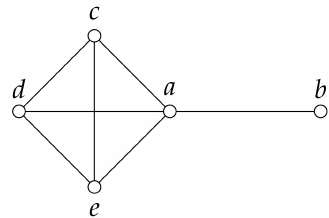
Figure 1. In this case, { a } is a dominating set, { a , b } is a total dominating set and also a secure dominating set, while { a , b , c } is a secure total dominating